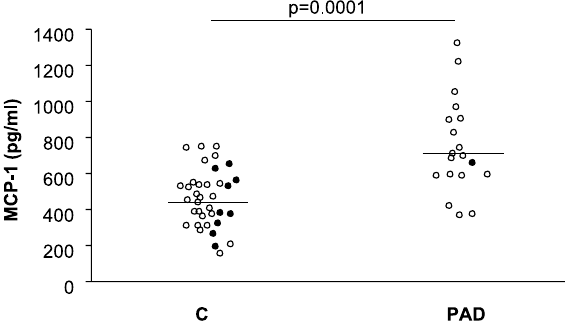
FIG. 1. MCP-1 serum levels (pg/ml) in healthy controls (C, n (cid:3) / 36) and in patients with PAD (n (cid:3) / 19). Open circles, individual MCP-1 values in male subjects; filled circles, chemokine values in female subjects; lines, median